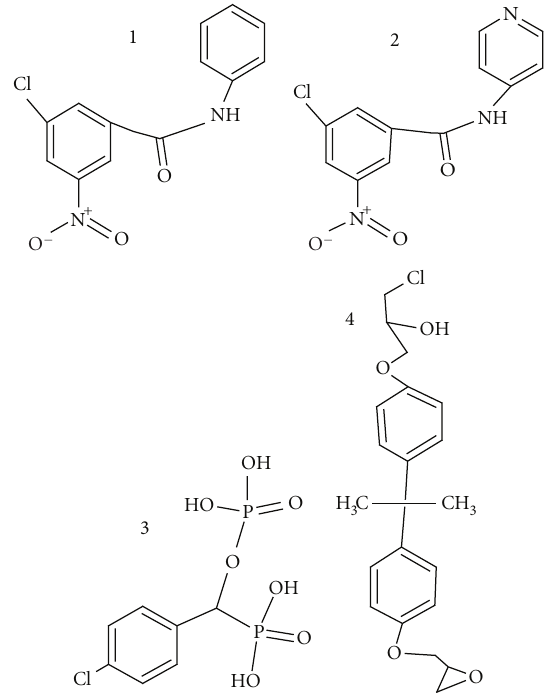
Figure 1: The chemical structures of four PPAR γ antagonists: (1) GW9662, (2) T0070907, (3) SR-202, and (4) BADGE.